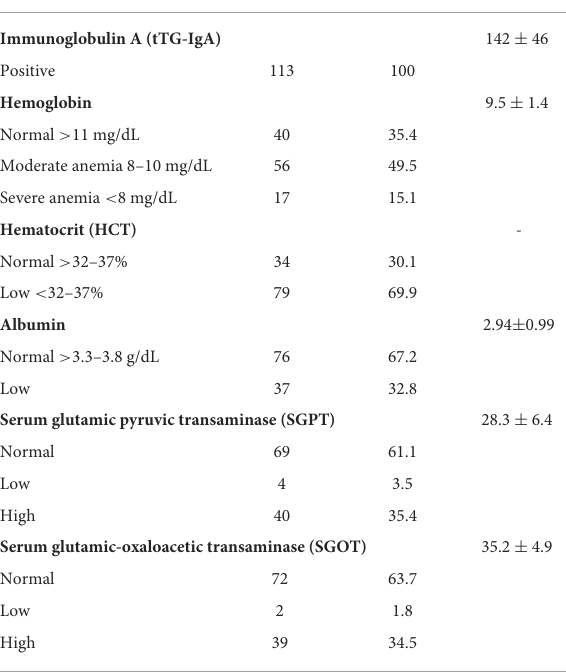
TABLE 3 Blood chemistry of patients with celiac disease. TABLE 4 Gastrointestinal complaints of patients with celiac